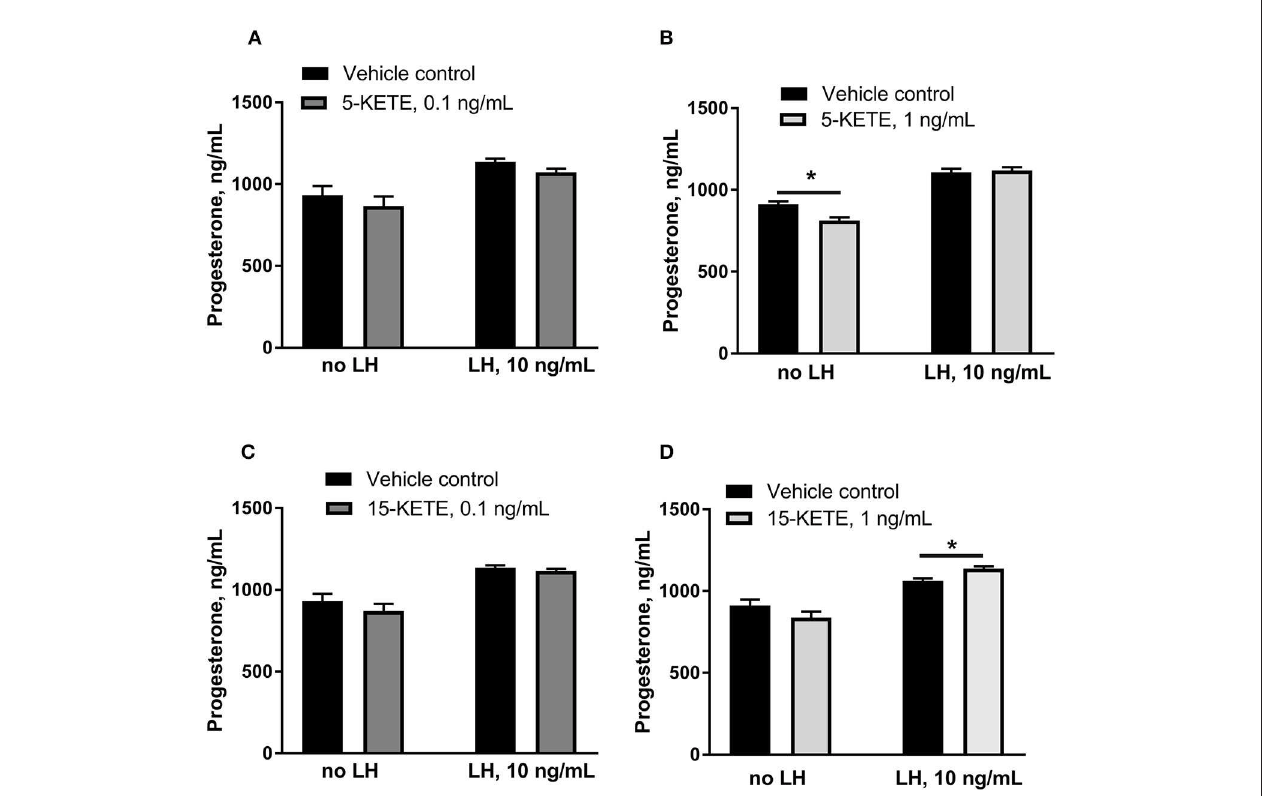
FIGURE 8 | Effect of 5-KETE and 15-KETE on progesterone production in cultured luteal cells on day 1 of culture. Significant differences ( P < 0.05) between lipid-treated and vehicle control are denoted with a *. The effect of 0.1ng/mL (A) or 1ng/mL (B) 5-KETE and of 0.1ng/mL (C) or 1ng/mL (D) 15-KETE ( N = 5 and N = 4 for without and with LH groups,